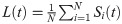
Time series of model variables as a function of interventions, direct (raising Ce, panels a—d) and through social pressure (raising U, panels e—h).The former intervention, panels a-d, means an increase of social pressure on people who choose to transport firewood (i.e. increasing the U value), and the latter refers to direct interception of firewood (i.e. increasing the Ce value). Terms L(t)=1N∑i=1NSi(t), I(t)=1N∑i=1NIi(t), B(t)=1N∑i=1NBi(t), L(t)=1N∑i=1NLi(t) are the averages of the state variables over all patches. S(t) has been omitted for brevity.